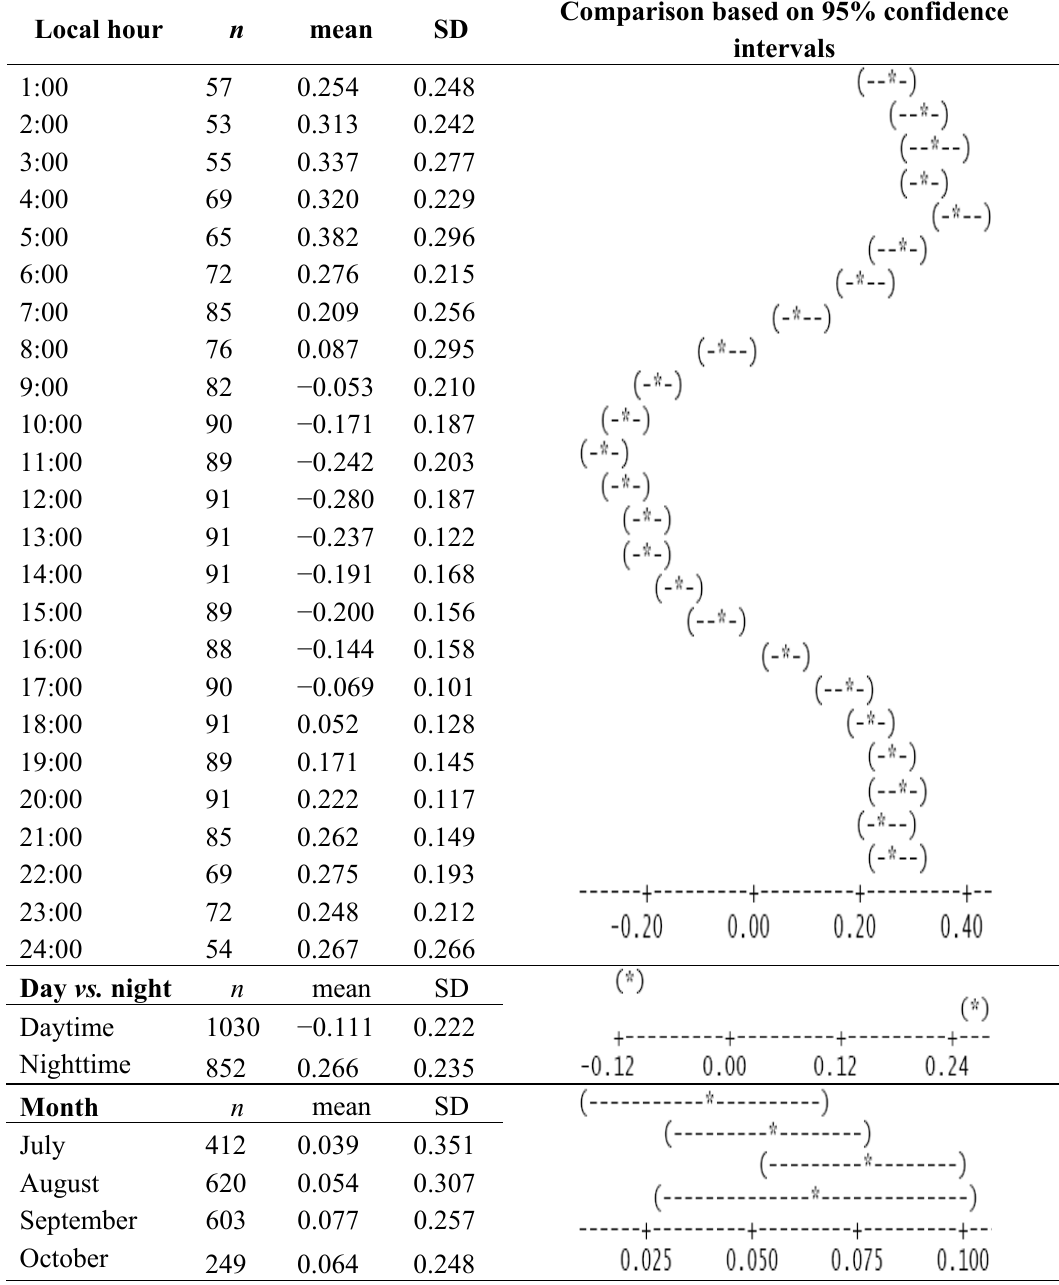
fluxes (mg CO m − 2 s − 1 ) in the Yenicaga c_wpl 2 Comparison based on 95%